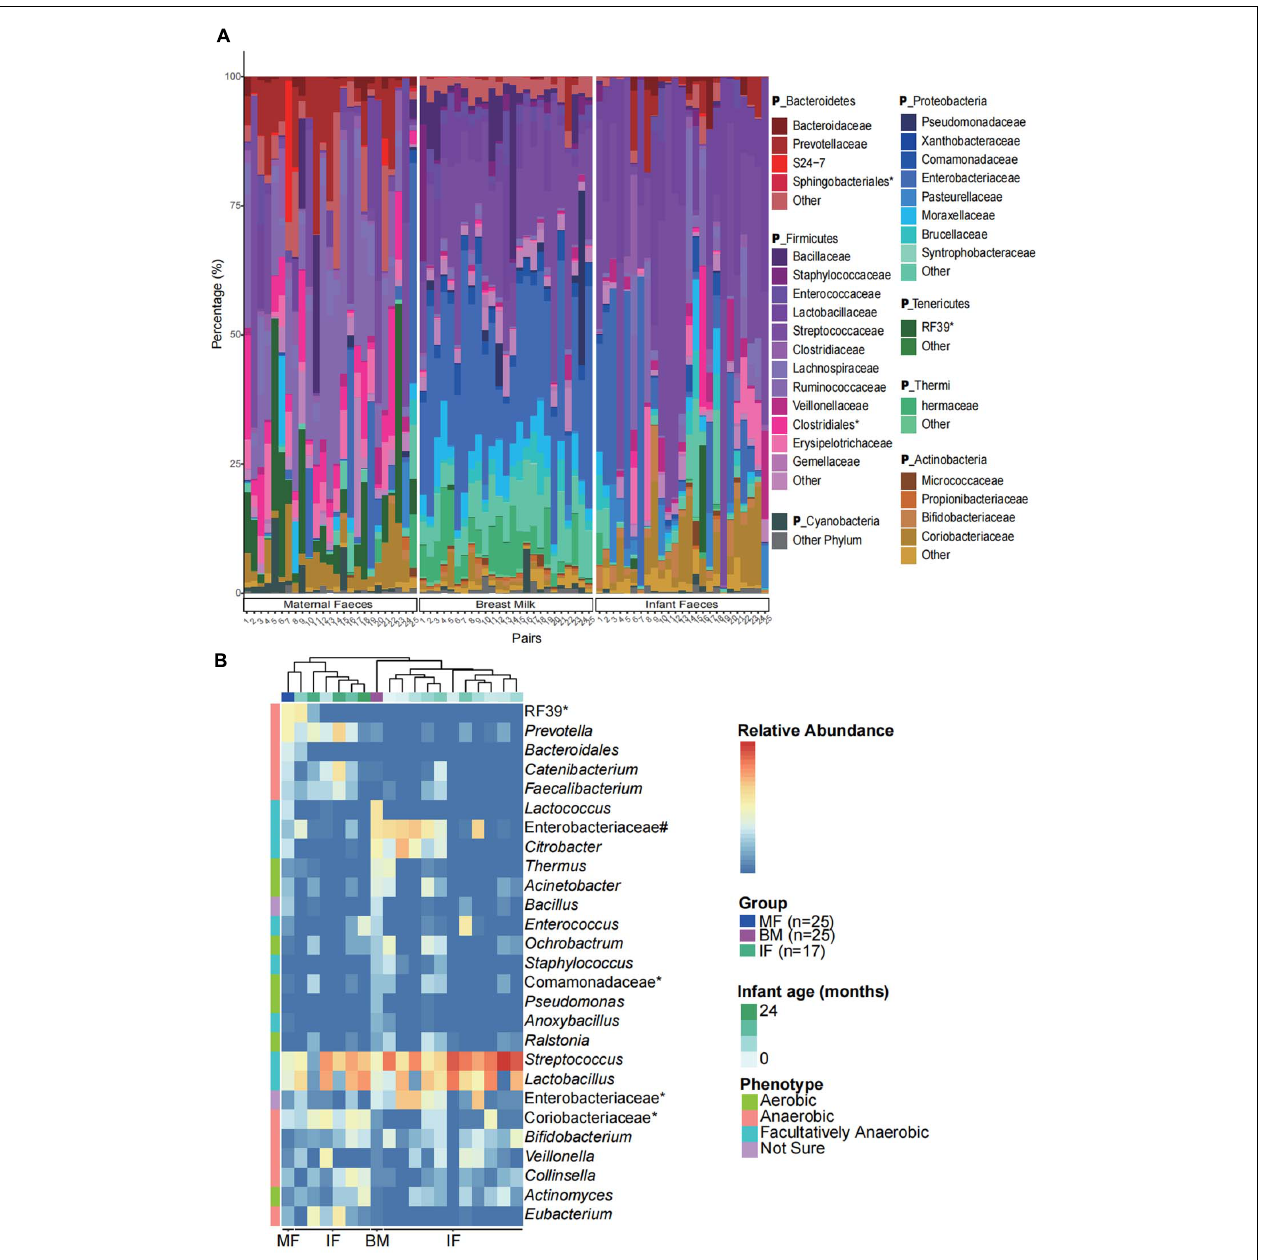
FIGURE 1 | Microbial community characteristics of the infant feces, maternal feces, and breast milk samples. (A) Community structure of the dominant bacteria in breast milk and feces samples of all infants and their mothers at the family level. IF, infant feces; MF, maternal feces; BM, breast milk. *The unclassified bacteria at the family level. The P_ in taxonomy labels indicate that the level of taxonomy is phylum. (B) The relative abundance of the biomarkers (at the genus level) in feces samples of 17 infants aged 0, 1, 2, 3, 4, 5, 6, 7, 8, 9, 11,12,13, 15, 20, 21, and 24 months (only one infant feces sample per month) and in feces and breast milk samples of all mothers ( n = 25). The groups are ordered by hierarchical clustering of Bray–Curtis dissimilarities. *The unclassified bacteria at the genus level. #Other genera of Enterobacteriaceae. The biologically interpretable phenotypes (oxygen tolerance) are predicted by algorithm